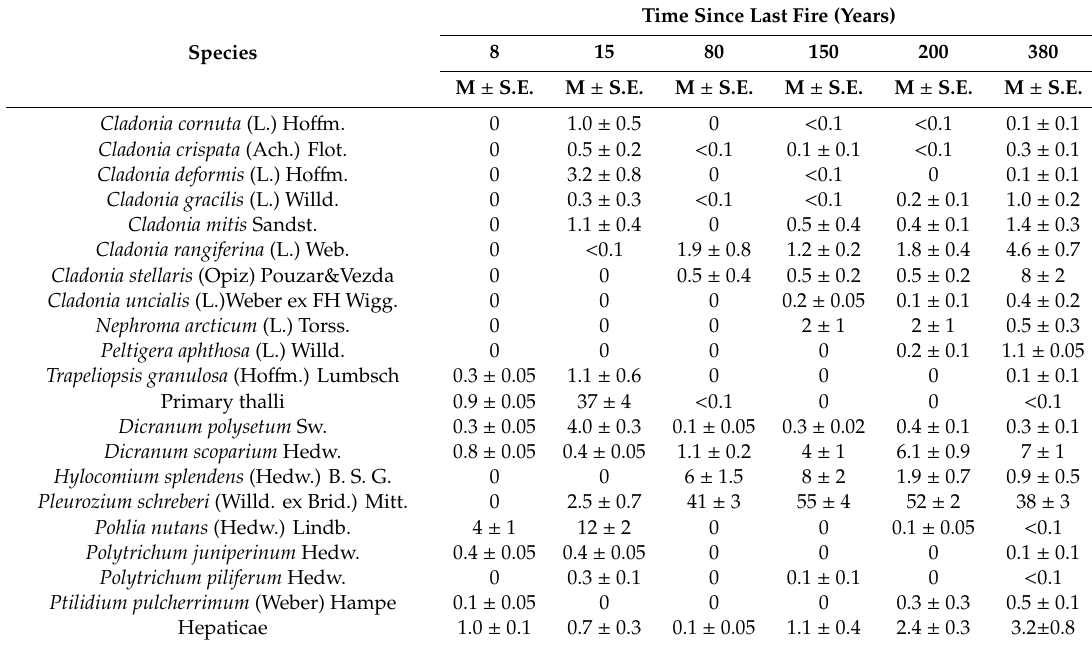
Figure 8. Total coverage ( a ) by lichens (open bars) and mosses (solid bars). Diversity characteristics ( b ): solid squares—number of species; open circles—Pielou’s index in Siberian Spruce–Scots pine forests with different post-fire periods. Table6. CoveroflichensandmossesinSiberianspruce–Scotspineforestswithdi ff